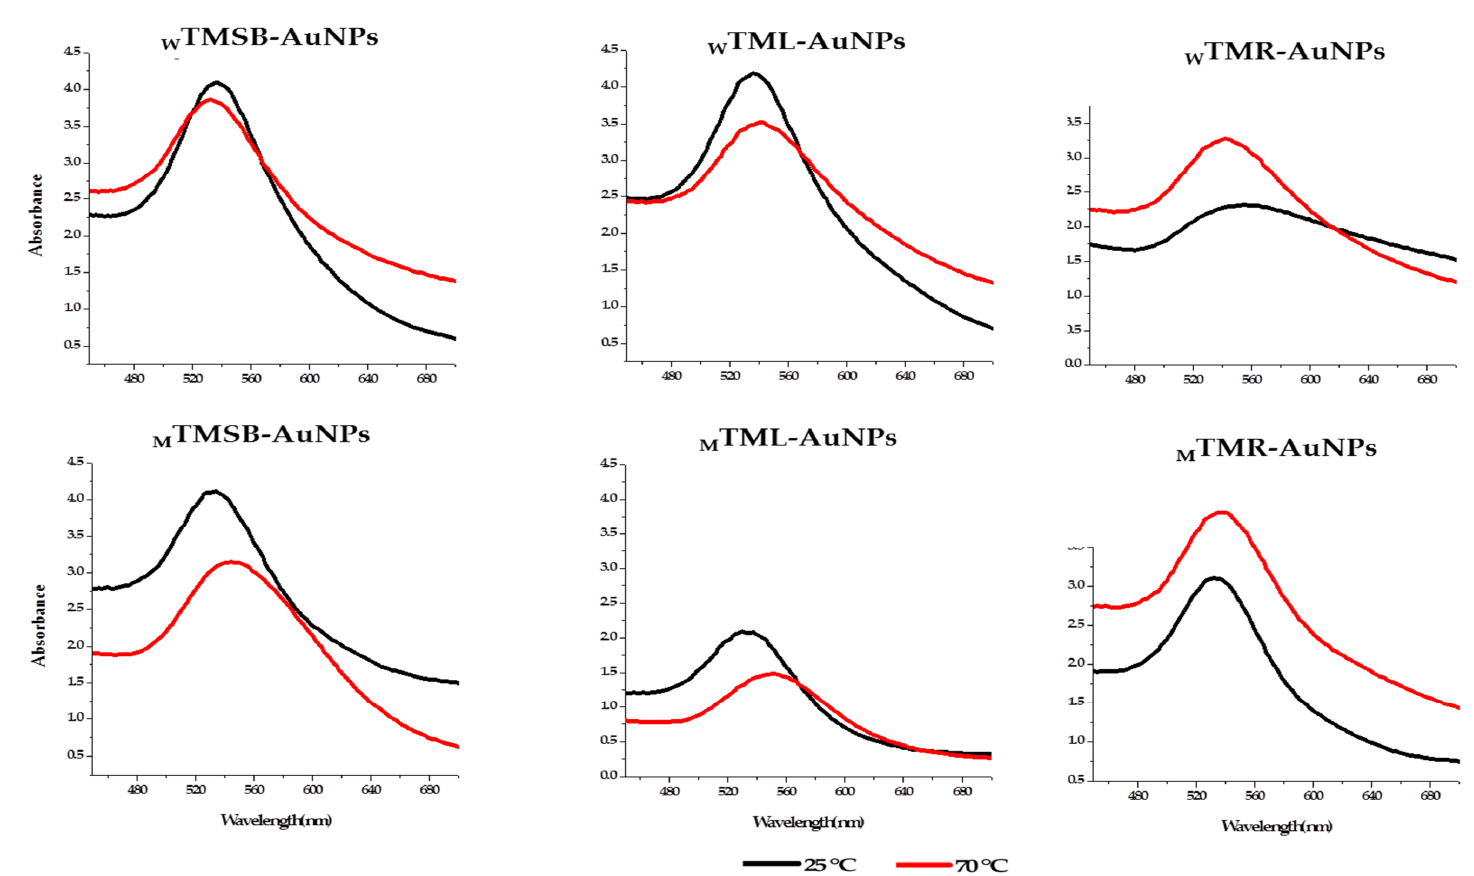
Figure 2 . The UV–visible spectra of TM-AuNPs. The AuNPs were synthesized at the optimal concentration (OC) of TM-extracts at 25 and 70 °C using W TM and M TM extracts.